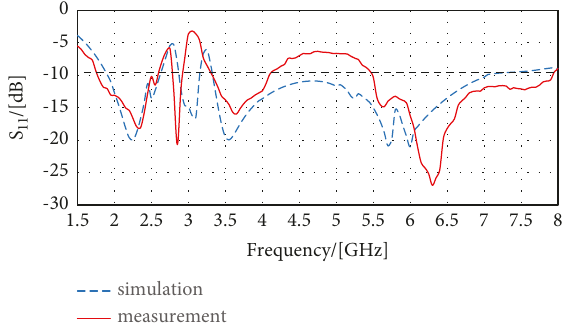
Figure 12: Comparison of antenna simulation and measurement.